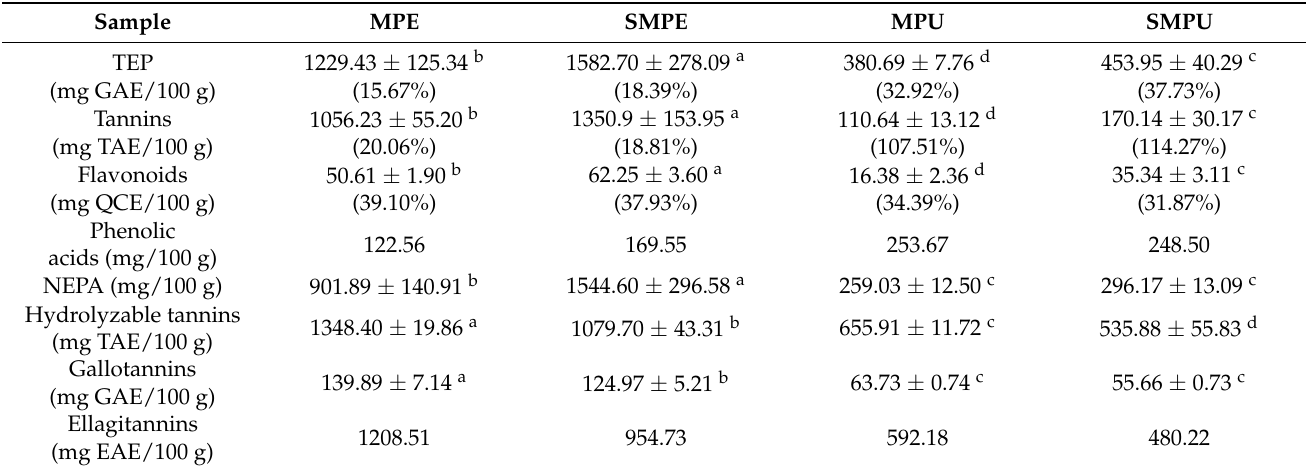
Table 3. Extractable and non-extractable phenolics content of umbu by-products (%